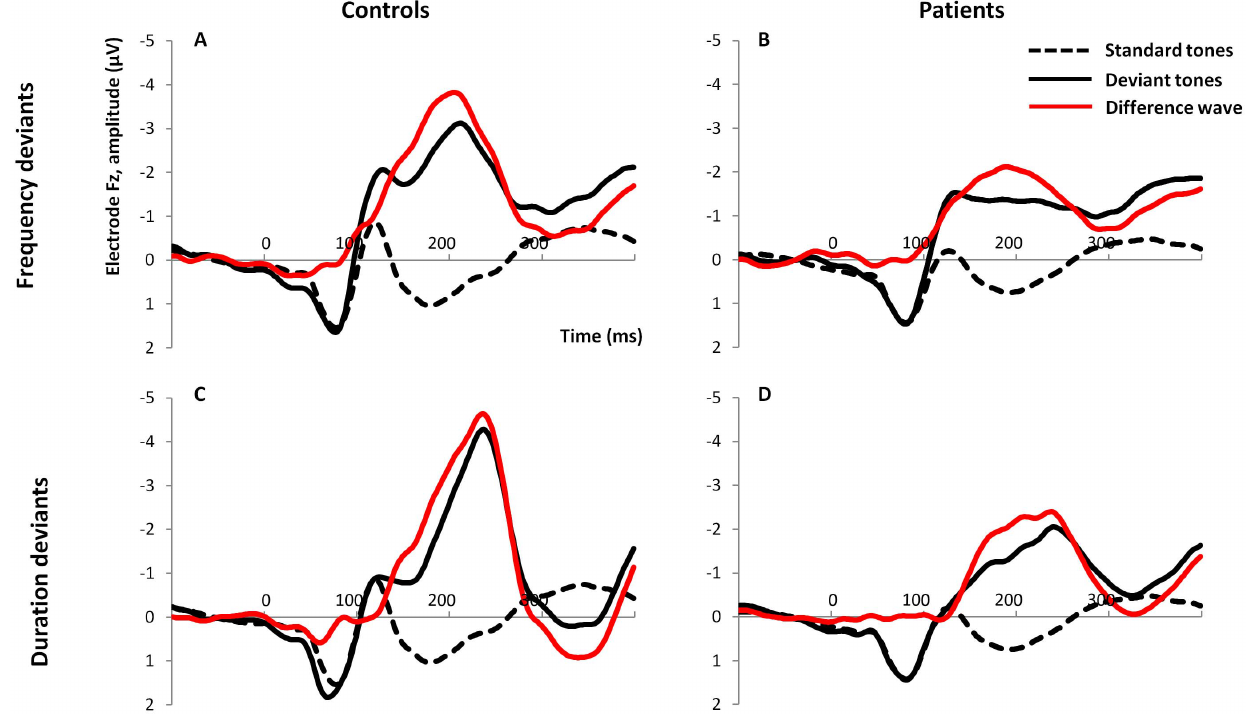
Figure 1. Grand averages of responses to standard and deviant tones and the resulting difference waveforms. Top: Frequency deviants in controls (A) and patients (B); bottom: Duration deviants in controls (C) and patients